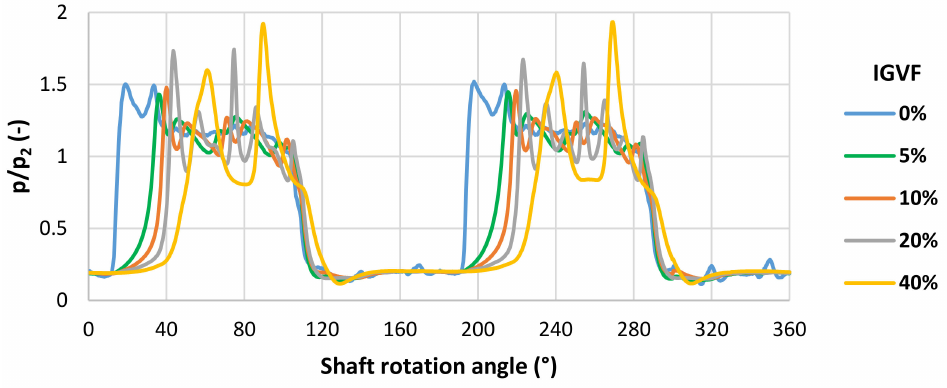
Figure 25. Displacement chamber pressure profiles for the BVP obtained from the CFD simulations at p 2 = 5 bar pressure load, 20 ◦ C oil temperature, 2000 rpm and different IGVF.